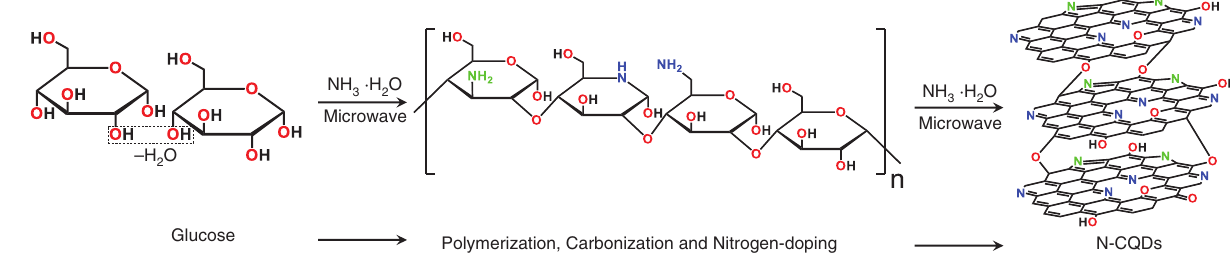
Figure 1: Schematic growth model for